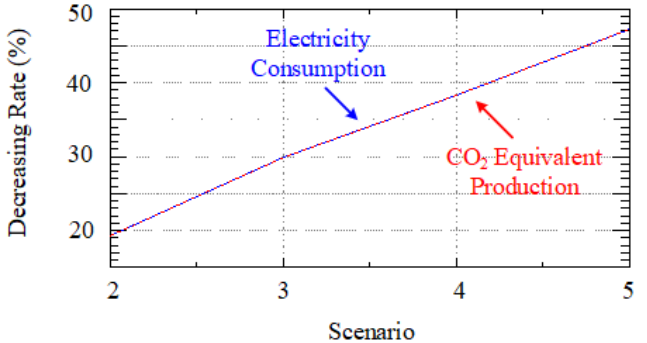
Figure 3. The CO 2 equivalent production of the Biochrom 30+ amino acid analyzer physiological system with the average HVAC system power rating.